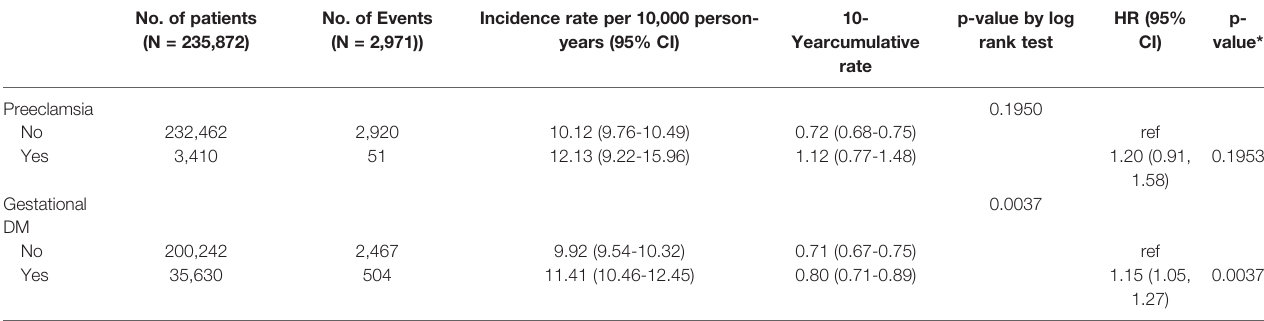
TABLE 3 | Incidence rate by pregnancy associated diseases (a) preeclampsia, (b) gestational diabetes mellitus in women who had fi rst delivery in 2007. No. of patients (N =